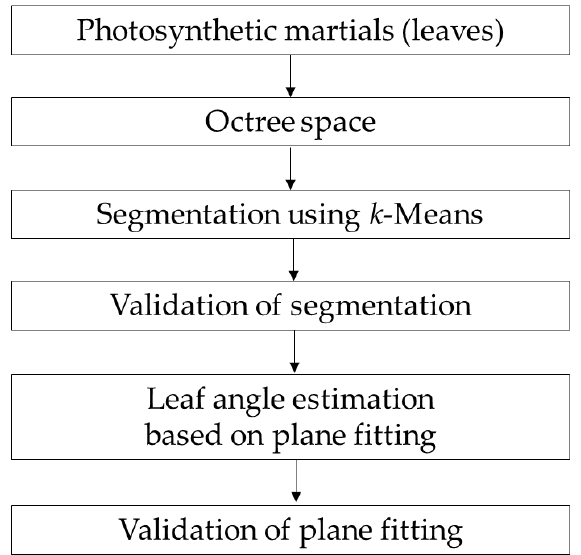
Figure 2. Workflow of leaf angle estimates.